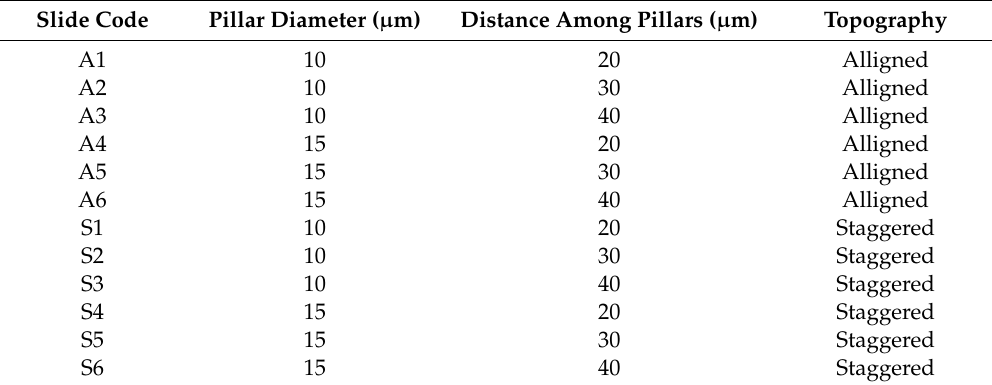
Table 1. List of di ff erent silicon slide arrays fabricated and tested in this work. Slide Code Pillar Diameter ( µ m) Distance Among Pillars ( µ m) Table 1. List of different silicon slide arrays fabricated and tested in this work. Slide Code